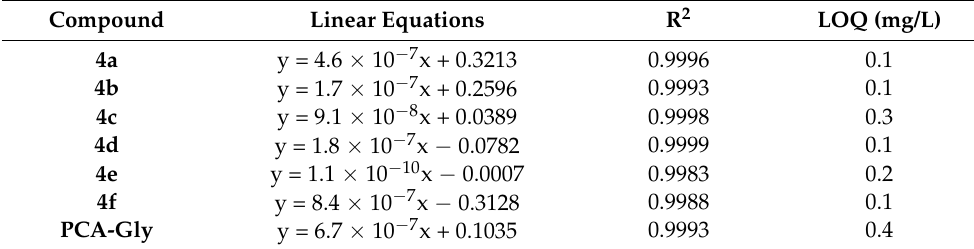
Table 5. The linear equations of the test compounds ( Ricinus communis